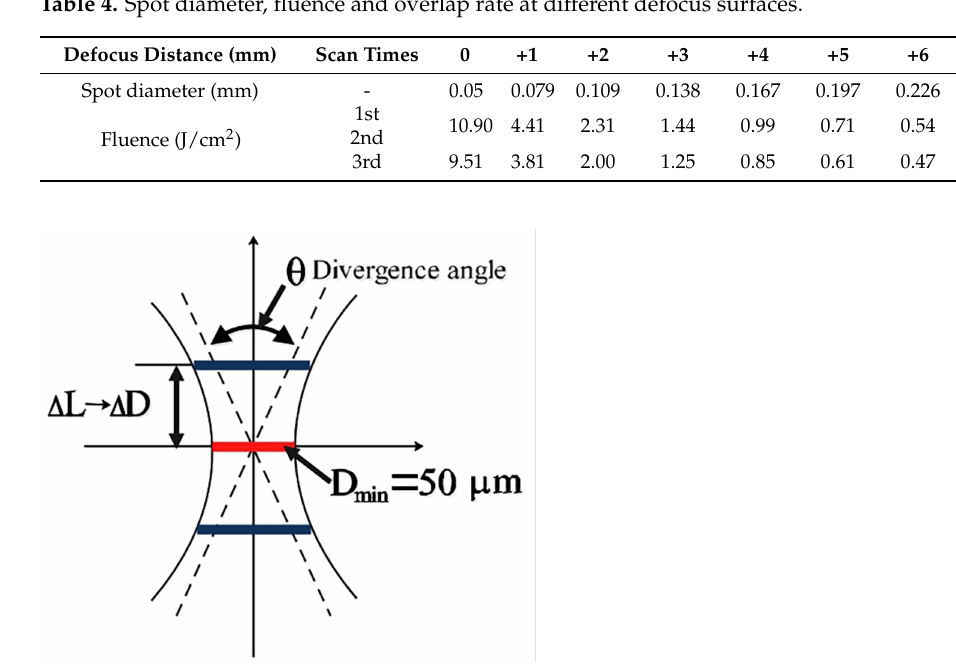
Figure 4. Schematic diagram of the size of light spot and defocus amount ( ∆ L : change in defocus amount, ∆ D : change in spot diameter caused by change in defocus